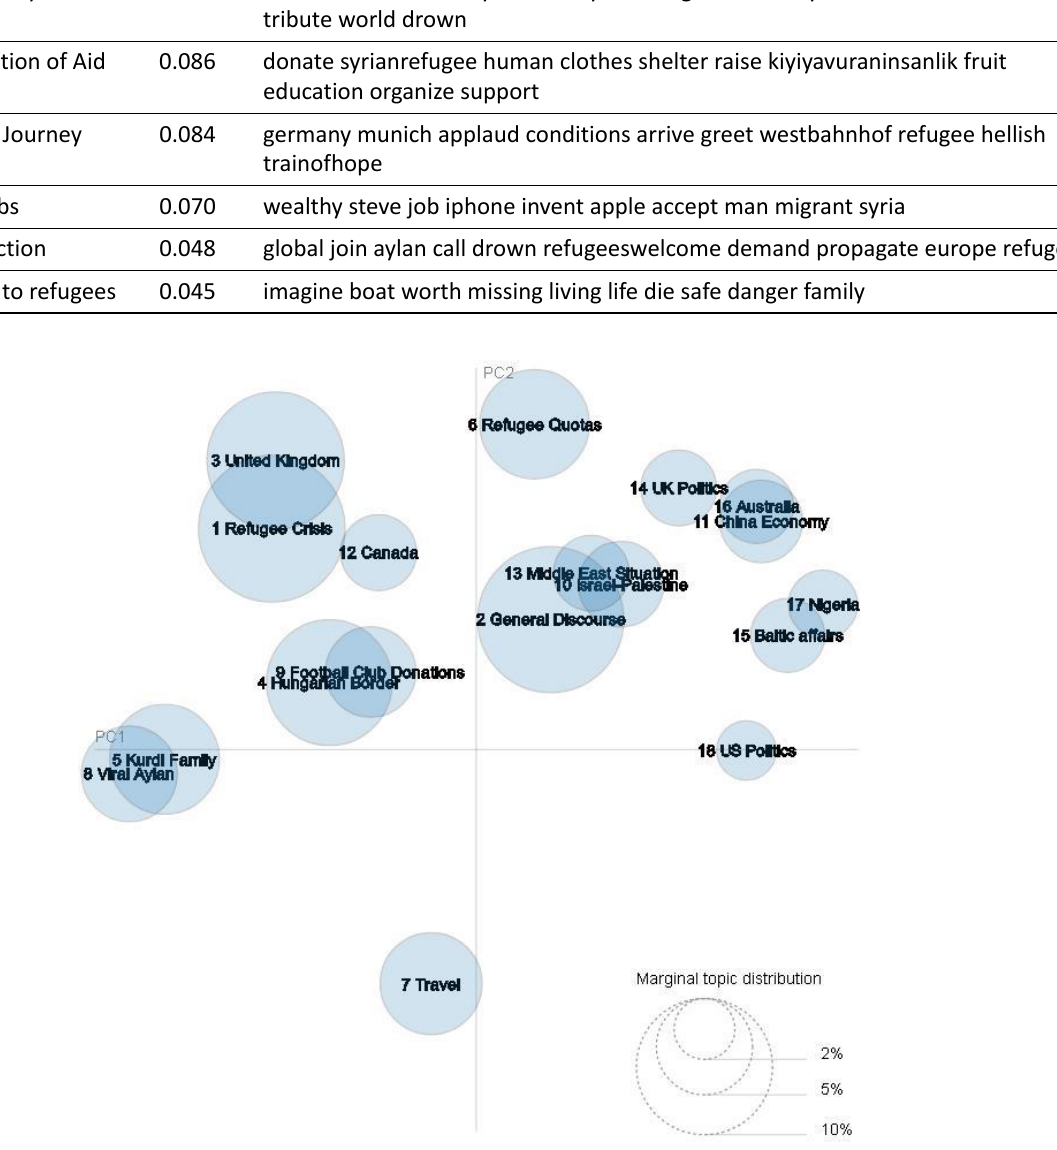
Figure 1. Intertopic distance map (via classical multidimensional scaling) of the newspapers’ topics. its solicitation of sympathy: “If you can’t imagine your- self in one of those boats, you have something